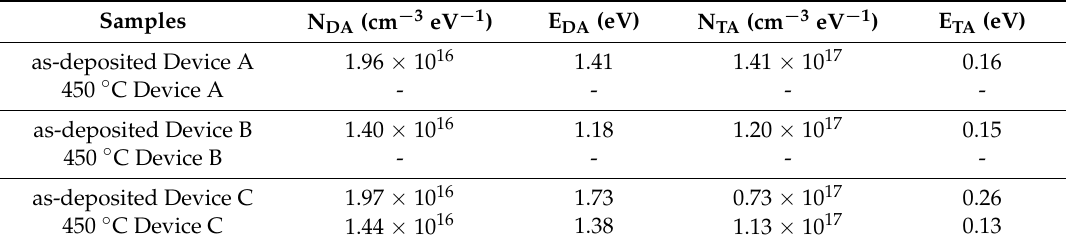
Figure 5. Extracted DOS of a-STO TFTs as function of E − E c : ( a ) as-deposited Device A, ( b ) 450 °C Device A, ( c ) as-deposited Device B, ( d ) 450 °C Device B, ( e ) as-deposited Device C and ( f ) 450 °C Device C. Inset is C-V curve of the corresponding a-STO TFT at 10 k Hz. Table 2. Comparison of DOS parameters of a-STO TFTs.